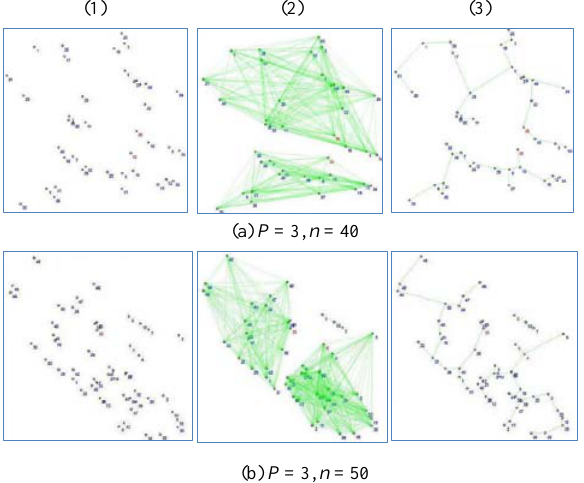
Figure 6. ( a ) 40 sensors distribution with p = 3; ( b ) 50 sensors distribution with p = 3. Example of the simulation: 1 , node distribution; 2 , fully connected graph based on chosen nodes near the sink node; 3 , constructing minimum spanning trees.